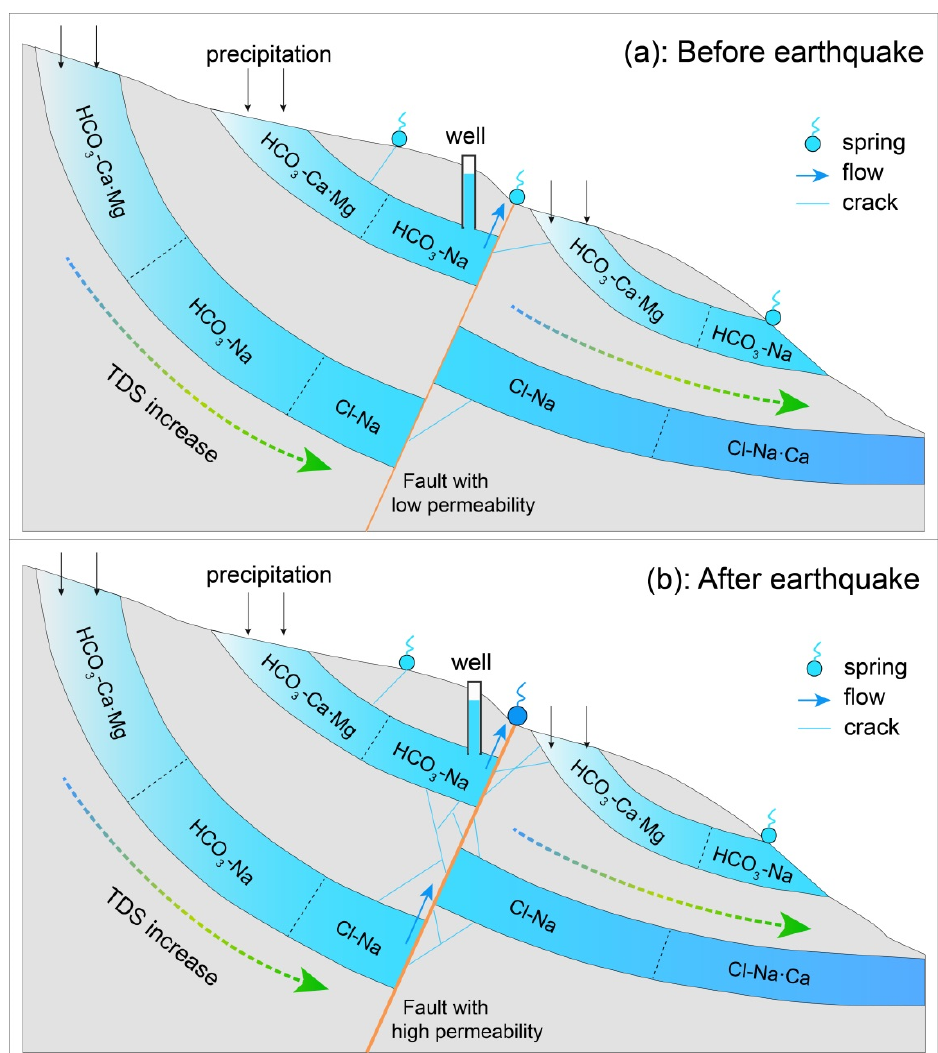
Figure 8. Schematic diagram of groundwater hydrochemical zonation and fracture variations before and after an earthquake. ( a ) before the earthquake, the hydrochemical composition of groundwater was in equilibrium, and the permeability in the fault zone was low; ( b ) earthquake triggered the formation of new fractures around the seismogenic fault, and the permeability of the fault also